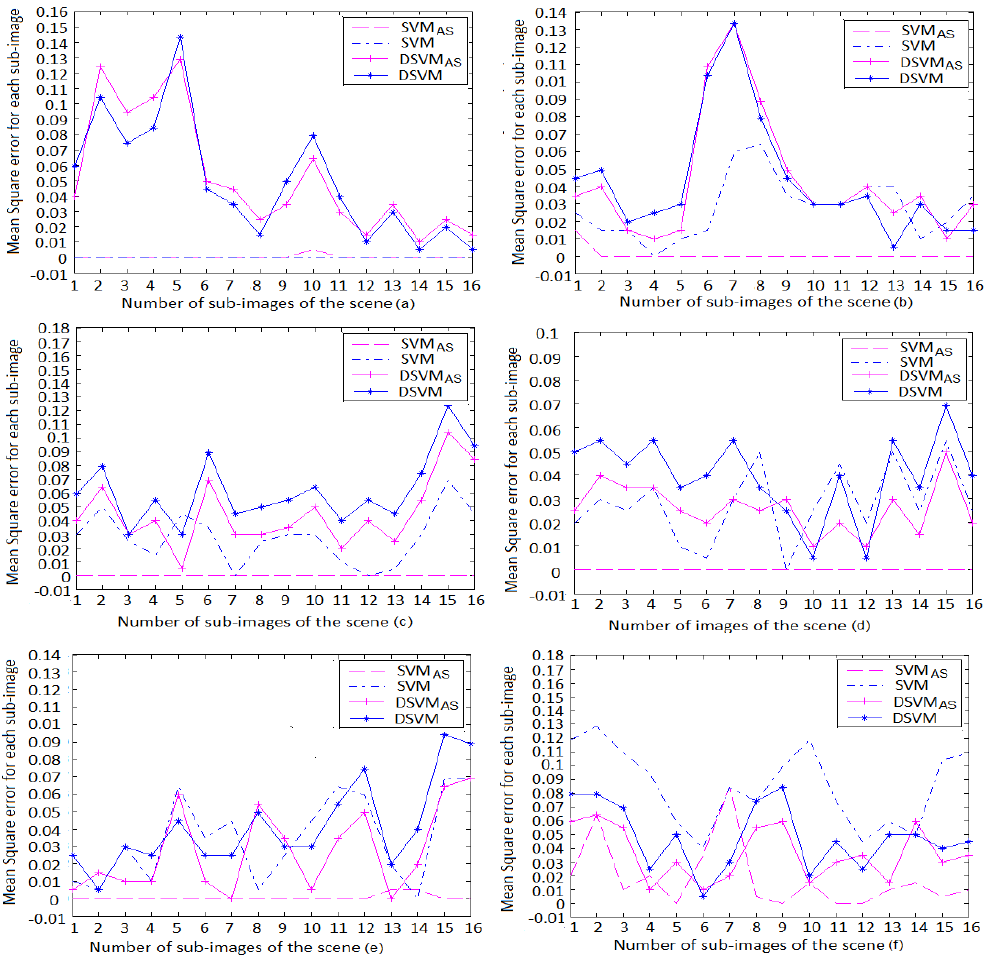
Figure 9. Variation of the mean square error for the 512 × 512 resolution scenes. It is shown that the SVM AS model achieves higher performance on the scenes ( b – f ). However, the SVM model assures higher performance than SVM AS on the learning scene ( a ). We also found that the DSVM AS model gives better performance than DSVM does on the scenes ( b – f ) and provides mean square errors less than SVM on the scenes ( d – f